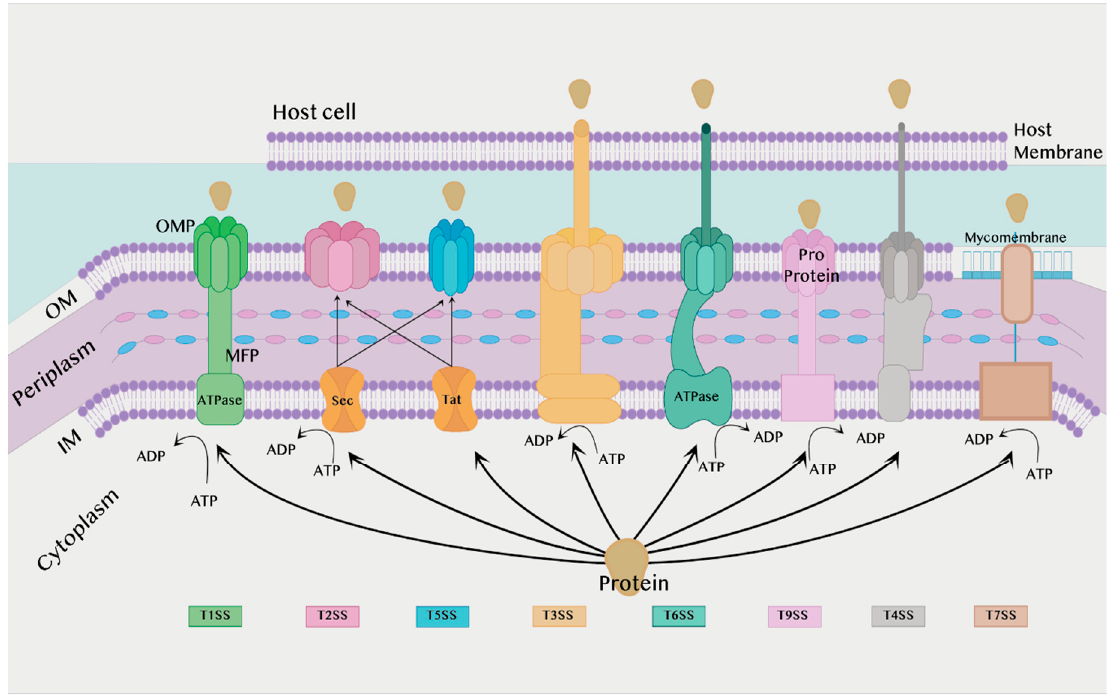
Figure 1. Different types of secretion systems. IM: Inner membrane. OM: Outer membrane. ATP: Adenosine triphosphate. ATPase: Adenosine triphosphatase. ADP: Adenosine diphosphate. MFP: Membrane fusion protein found in the T1SS. OMP: Outer membrane protein.